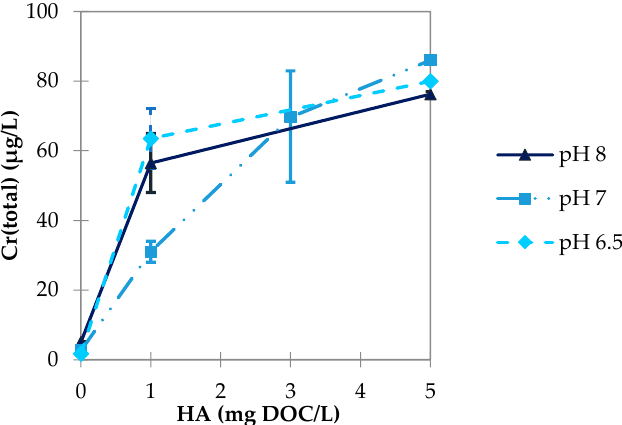
Figure 8. Cr(total) residual concentrations as a function of the presence of HAs (0, 1, 3, 5 mg DOC/L) at pH values 6.5, 7, and 8 and at Fe(II) dosage 2 mg/L. Mean values with vertical bars indicate the range. The results were obtained by the application of both set-ups A and B.